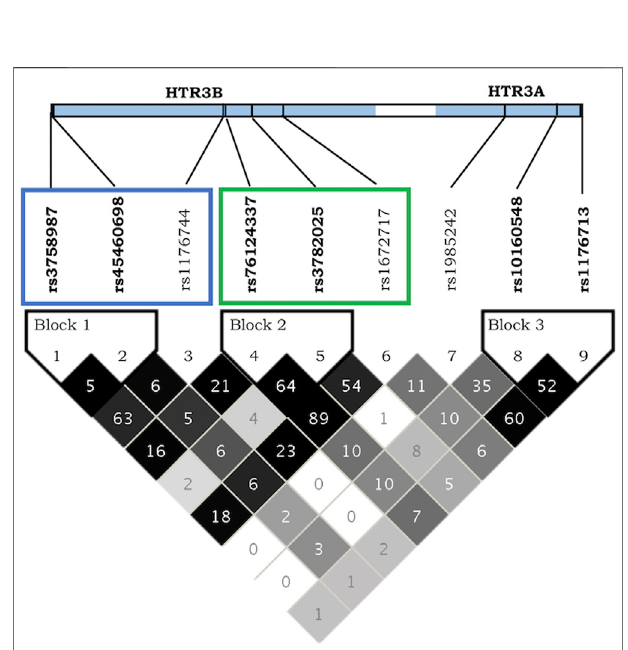
FIGURE 2 | LD plot for HTR3A and HTR3B receptors on Chromosome 11. The shading of the haplotype boxes indicates the magnitude of LD coef fi cient D ’ , with darker color indicating stronger LD. 100-fold pairwise r 2 squared numbers are displayed. Blue rectangle highlights HTR3B mutations with positive in fl uences on PONV prediction while the green box indicates HTR3B mutation with increased risks of PONV. Produced with Haploview (Barrett et al.,